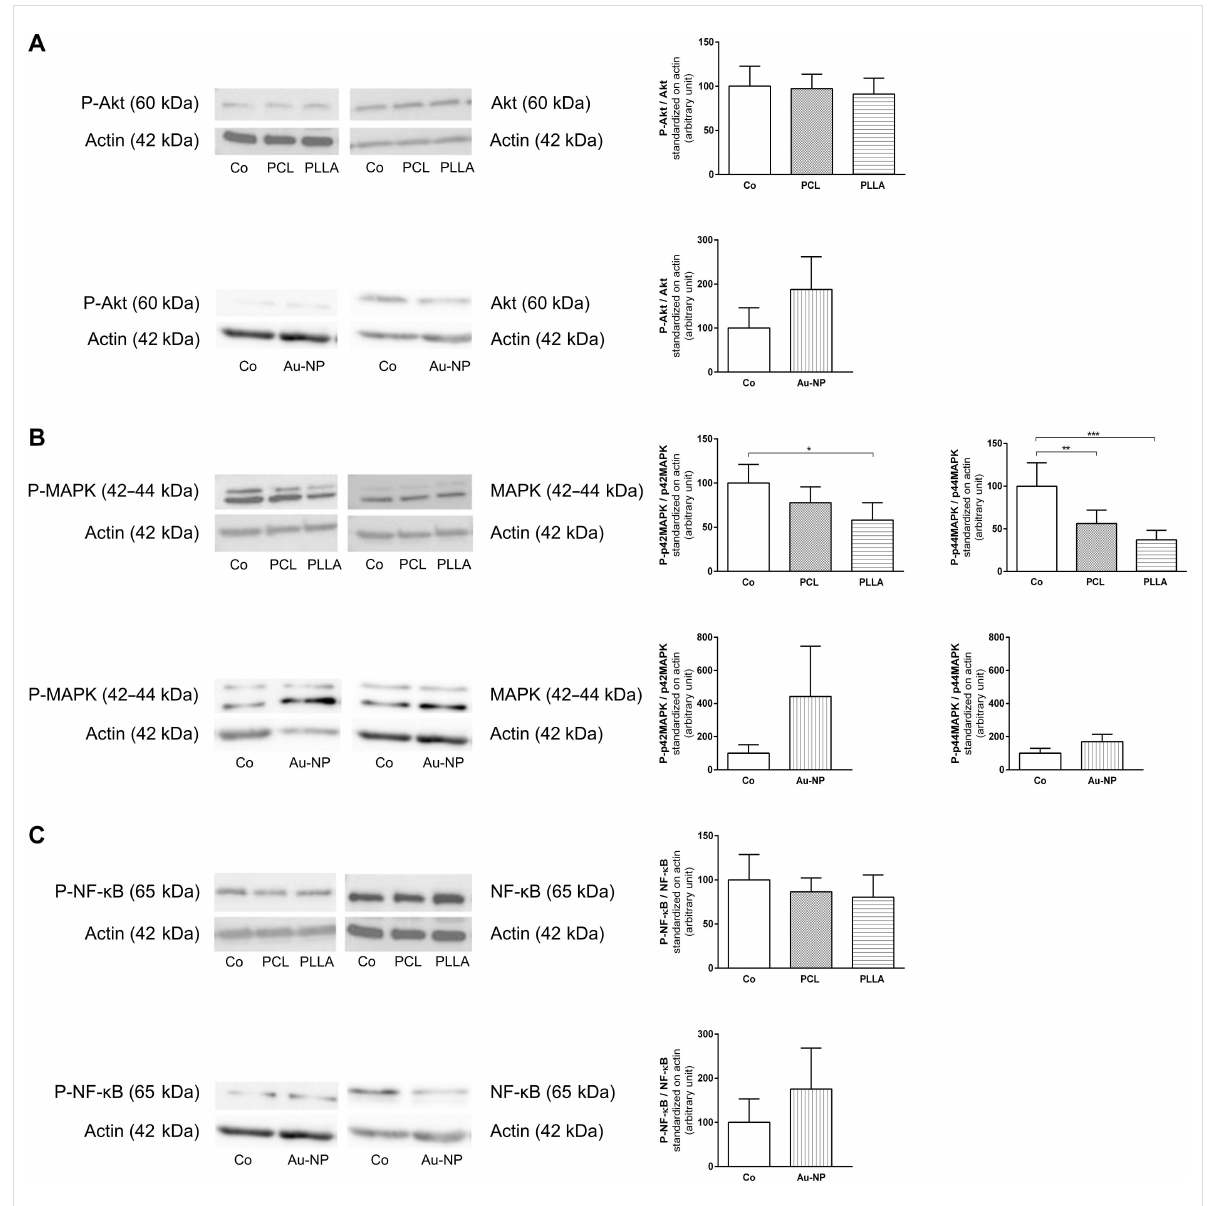
Figure 4: Effects of PCL-, PLLA- and Au-NP exposure on various signaling pathways. Expression of phosphorylated and unphosphorylated forms of crucial proteins of the Akt, the MAPK and the NF- κ B pathway after 24 h of exposure to all three NP types was quantified and the ratios (phosphorylat- ed/unphosphorylated) were calculated. PCL-, PLLA- and Au-NPs did not affect expression or activation of Akt or NF- κ B (A, C). PCL- and PLLA-NPs led to decreased levels of P-MAPK, whereas Au-NPs caused an increase (B). Representative western blot images are depicted on the left; quantifica- tion is shown on the right. Co: control. Concentrations were [24.9 µg/mL] for PCL- and PLLA-NPs and [160.3 µg/mL] for Au-NPs. Error bars represent SEM. Significant differences between NP-exposed and non-exposed controls are labeled with asterisks (*) (* = p ≤ 0.05; ** = p ≤ 0.01; *** = p ≤